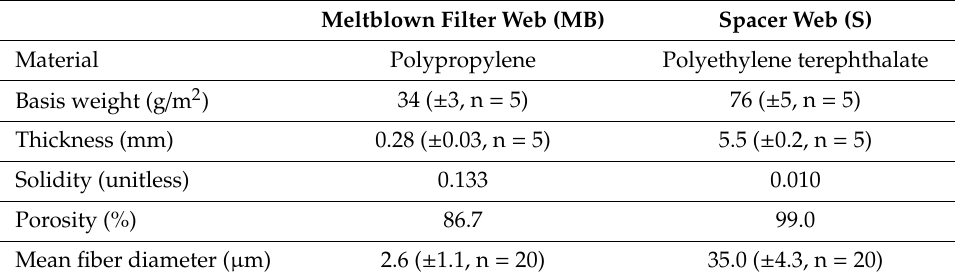
Table 1. Characteristics of nonwoven materials.